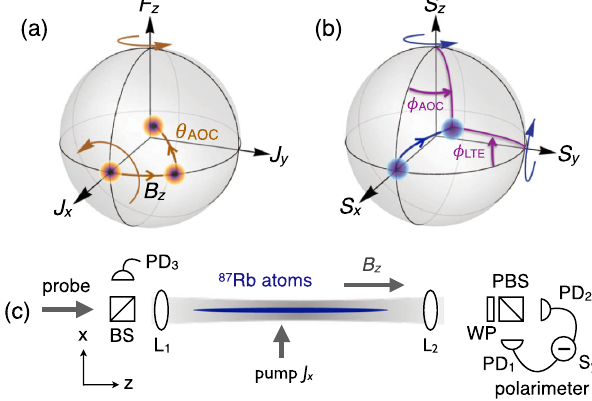
FIG. 1. Alignment-to-orientation conversion measurement of atomic spins. (a) An unknown field B z rotates an initially ˆ J ˆ J ˆ J − ˆ J x -polarized state in the x y plane. The y component is ˆ S detected using an x -polarized probe, which produces a rotation ˆ S ˆ J ˆ J θ ¼ κ = 2 . (b) Simultaneously, of y toward z by an angle 2 x AOC ˆ S paramagnetic Faraday rotation produces a rotation of x toward ˆ S ˆ J Φ ¼ κ κ N = 4 , which is y . The net effect is a rotation 1 2 L y AOC ˆ S observed by detecting y . In an alternative strategy, the linear-to- ˆ S ˆ S ˆ J Φ ¼ κ elliptical rotation of x toward z by the angle 2 y can be LTE ˆ S observed by detecting z . (c) Experimental geometry. Near- resonant probe pulses pass through a cold cloud of 87 Rb atoms and experience a Faraday rotation by an angle proportional to the ˆ J on-axis collective spin z . Atoms are prepared in a coherent spin ˆ J state x via optical pumping. The pulses are initially polarized ˆ S with maximal Stokes operator x , measured at the input by a ˆ S photodiode (PD 3 ). Rotation toward y is detected by a balanced polarimeter consisting of a wave plate (WP), polarizing beam splitter (PBS), and photodiodes (PD 1 ; 2